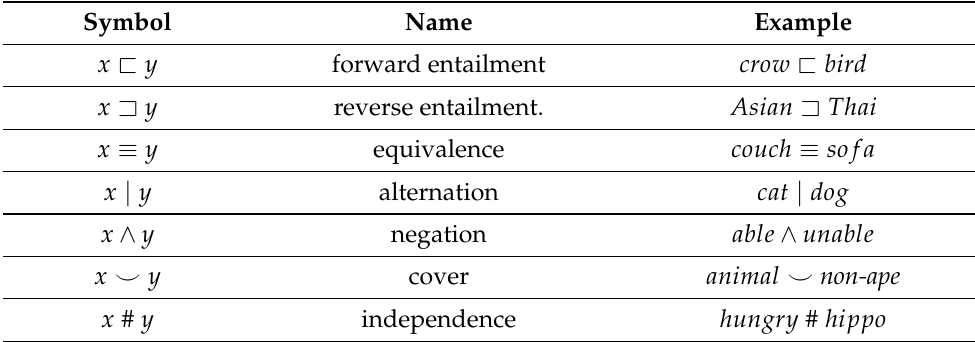
Table 2. Word level entailment relation examples in MacCartney’s thesis [17].